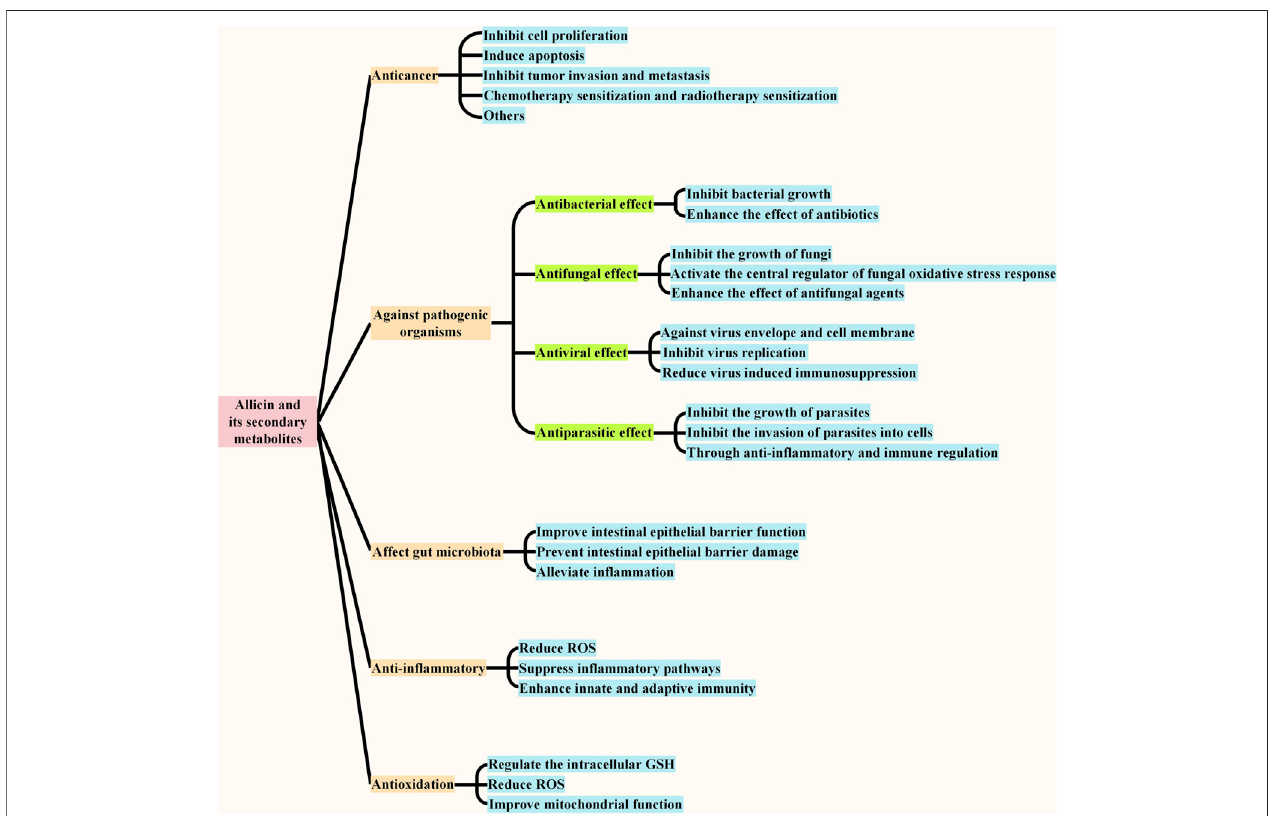
FIGURE 4 | | Biological functions of allicin and its secondary metabolites. The main physiological functions of allicin and its secondary metabolites include anticancer,actingagainstpathogenicorganisms,affectinggutmicrobiota,antioxidantandanti-in fl ammatory,andtheeffectsagainstpathogenicorganismsincludeanti- bacterial effect, anti-fungal effect, anti-viral effect, and anti-parasitic effect. The main effect of each function is summarized in the fi gure.